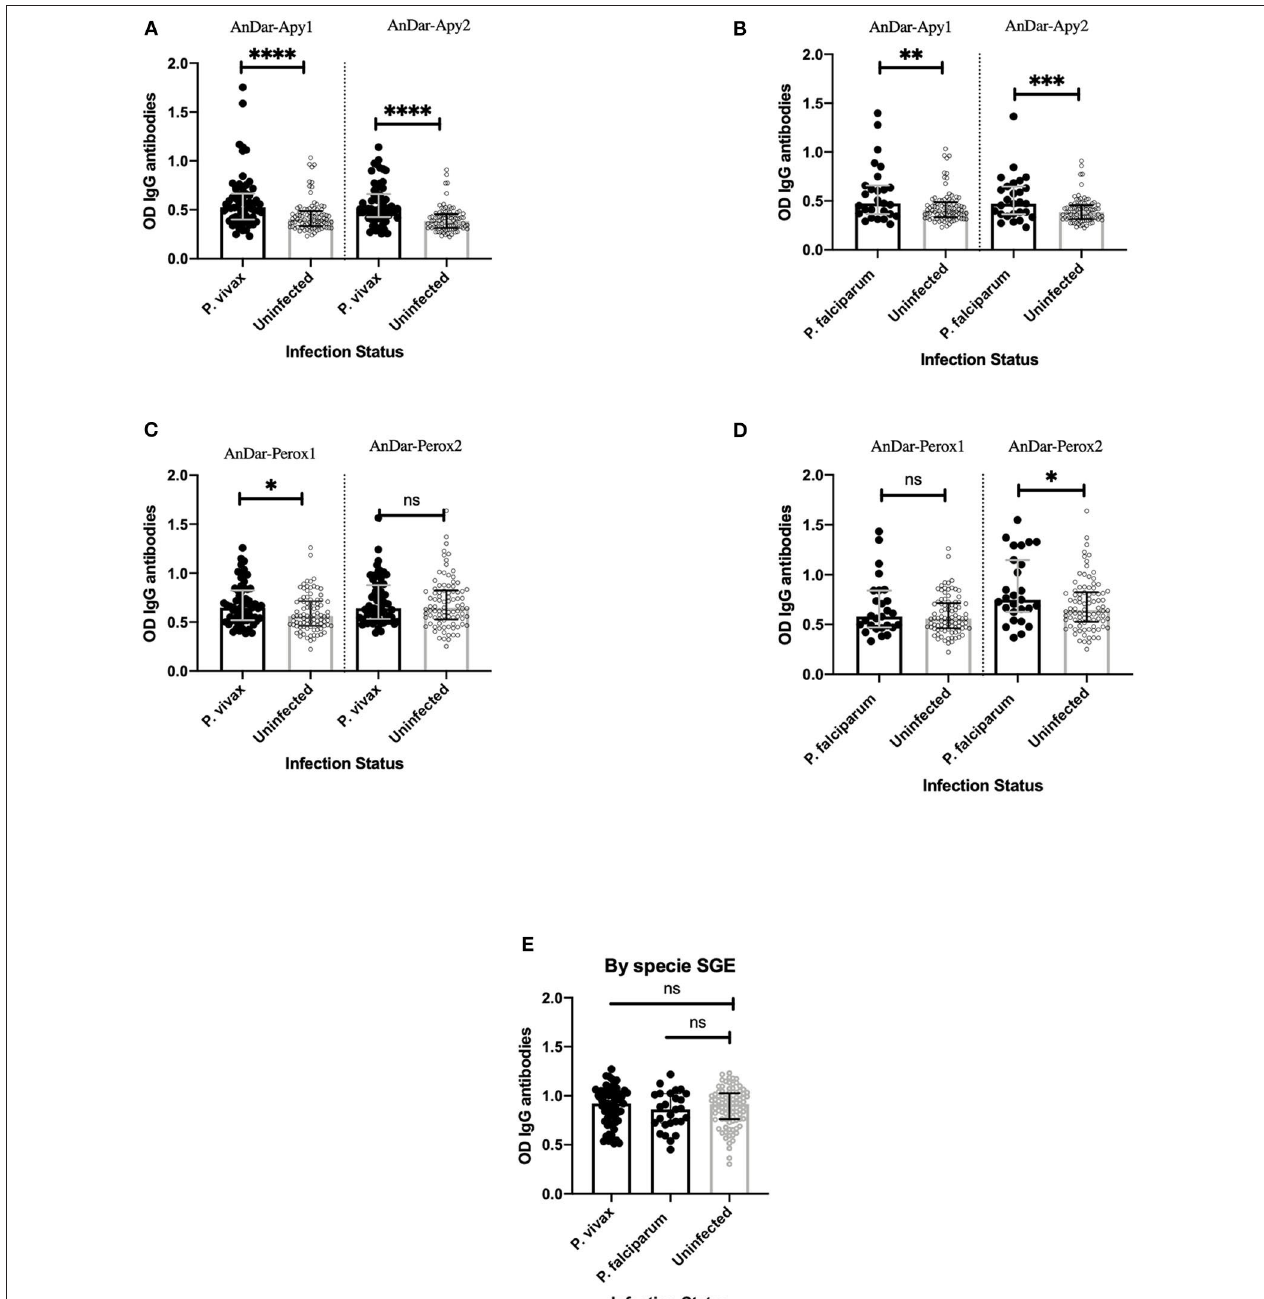
FIGURE 4 | Comparison of IgG antibody levels against An. darlingi apyrase peptides (A,B) , peroxidase peptides (C,D) , and SGA (E) , in samples from individuals infected with either P. falciparum or P. vivax . ns denotes not significant, p < 0.05 (* = 0.01 to 0.05, ** = 0.001 to 0.01, and *** = 0.0001 to 0.001).